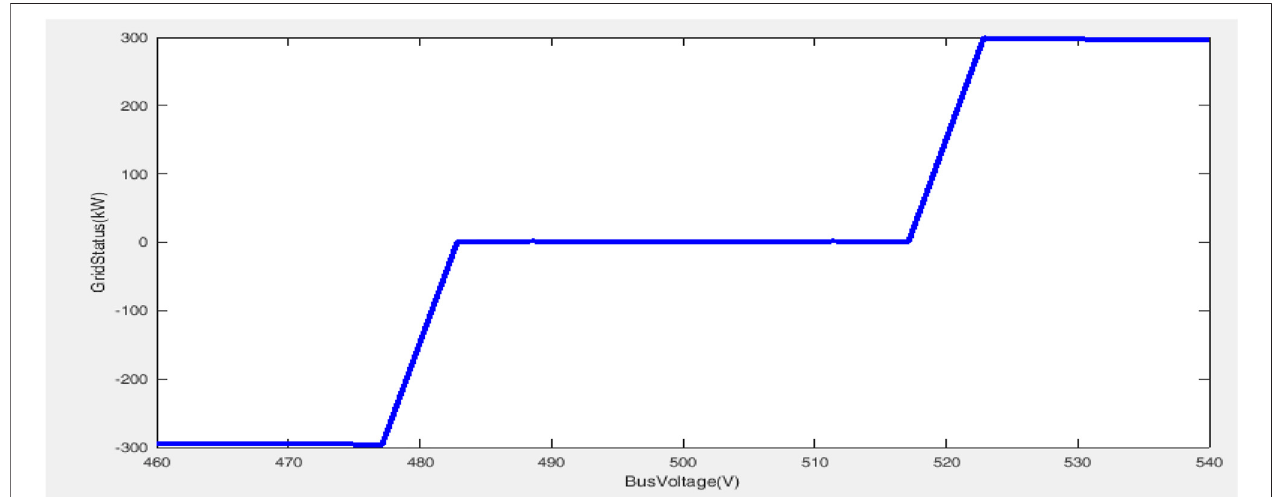
FIGURE 7 | Surface view of Grid Status.